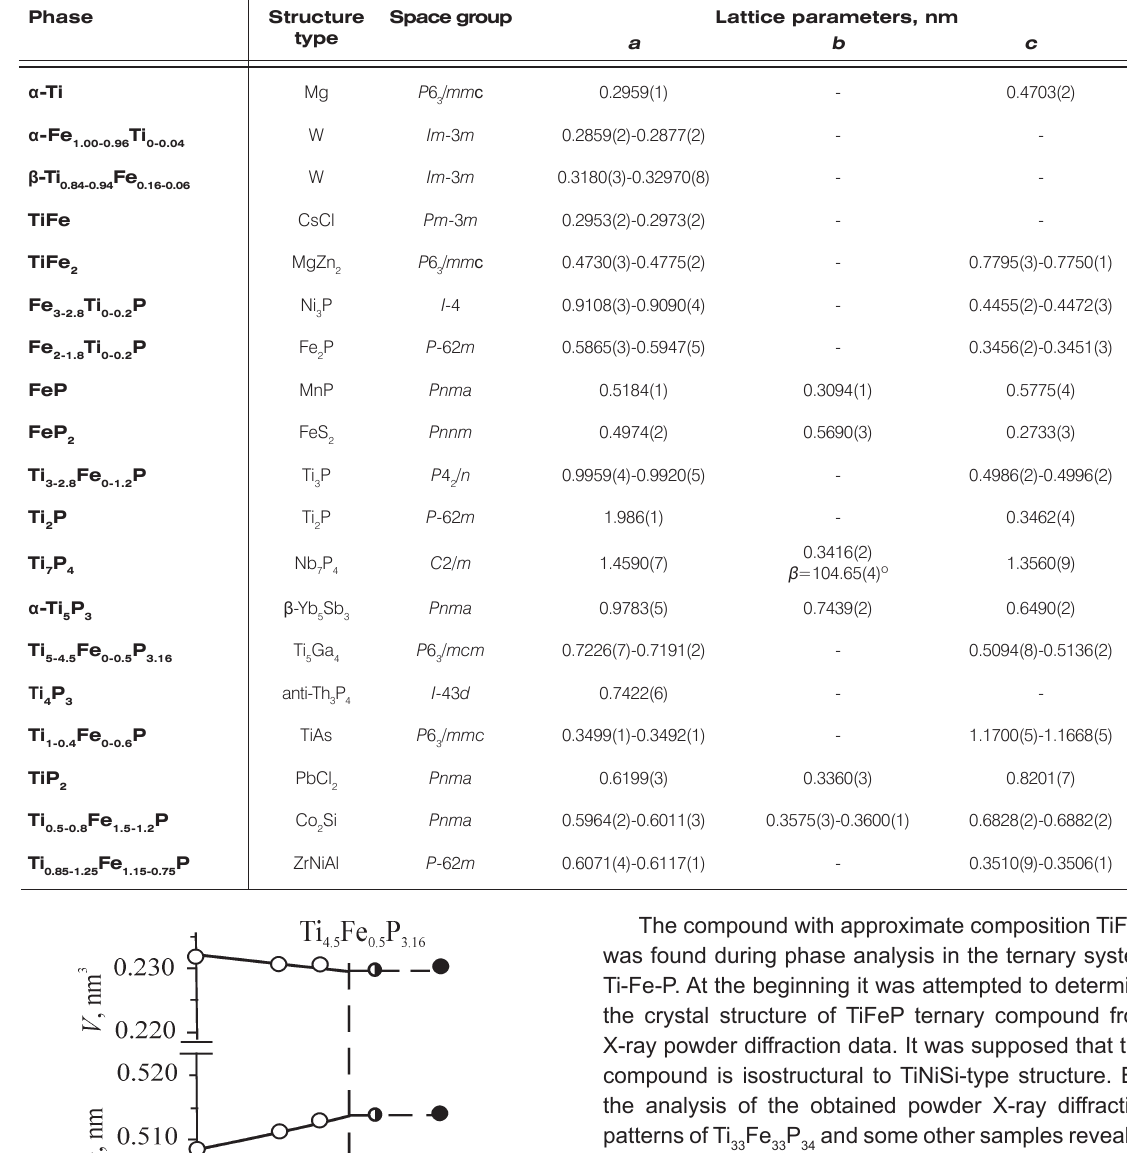
Table 1. Crystallographic characteristics of the phases in the Ti-Fe-P system.